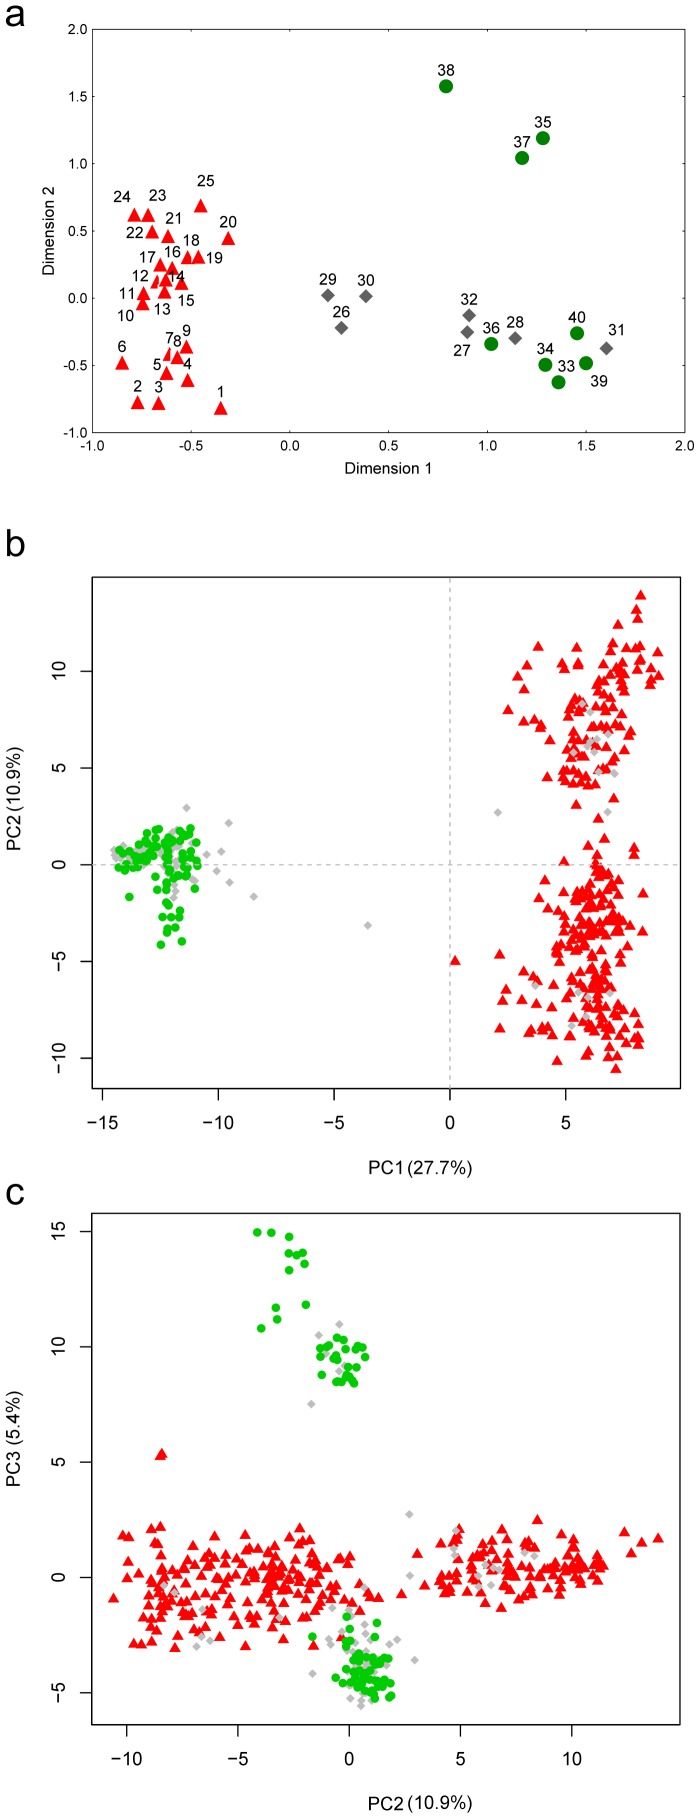
Genetic differentiation between L. montandoni (Lm) and L. vulgaris (Lv).(a) Non-metric two-dimensional scaling of the matrix of pairwise F
ST between populations; red triangles – Lm; green circles – Lv; grey diamonds – syntopic populations; (b) and (c) Principal Component Analysis (PCA) performed on individual genotypes; in parentheses percentage of variance explained by principal components; red triangles – Lm; green circles – Lv; grey diamonds – individuals from syntopic populations.